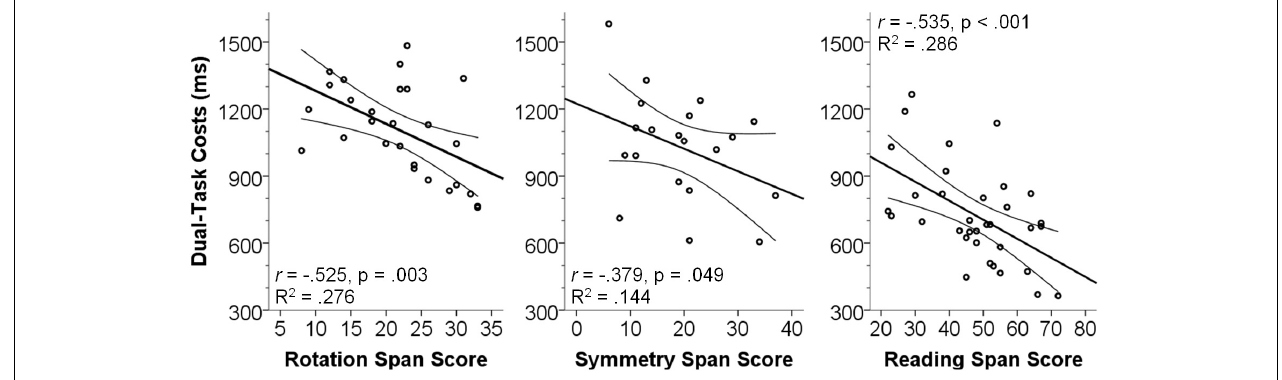
FIGURE 3 | Scatterplots illustrating the association between dual-task costs and measures of working memory capacity. Dual-task costs (ms) were calculated as dual-task response times (RT2) minus single-task response times. Span scores are the raw partial scores. Error lines show the SEM of the best line of fit.